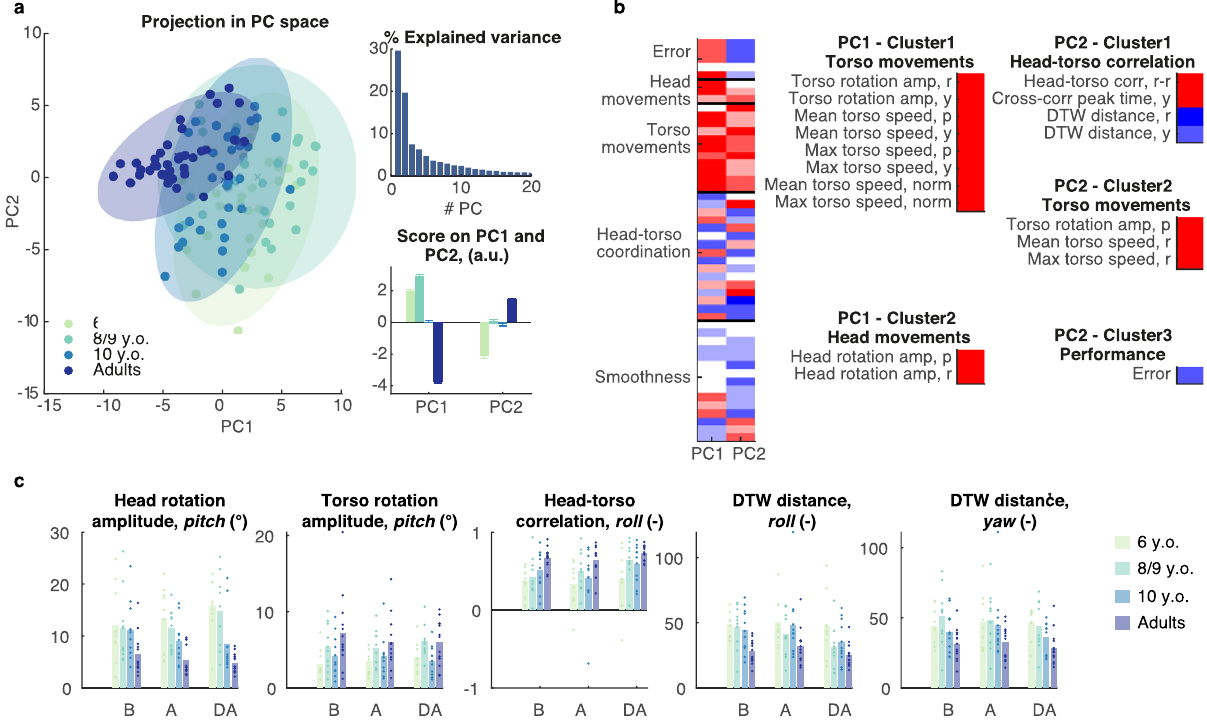
Figure 3. Efficient selection of head–torso coordination strategy develops with age. ( a ) PCA applied to the data collected on torso-controlled trials. The projection of the data in the space spanned by the first two PCs displays an age-based separation along the first two components (left) representing respectively 29.6% and 19.7% of the overall variance (top right). Group means of the scores on the first two PCs (bottom left, mean + SEM). ( b ) Normalized loadings of the descriptive variables on the first PC (left) and variables with absolute loadings higher than a threshold of 0.75 grouped into functional clusters. ( c ) Representative variables selected from the functional clusters with significant effect of Age. Dots represent the average value for each individual participant, bars the average across participants. N = 9 (6 y.o.), 12 (8–9 y.o.), 11 (10 y.o.), 13 (adults). B: Before, A: After, DA: Day